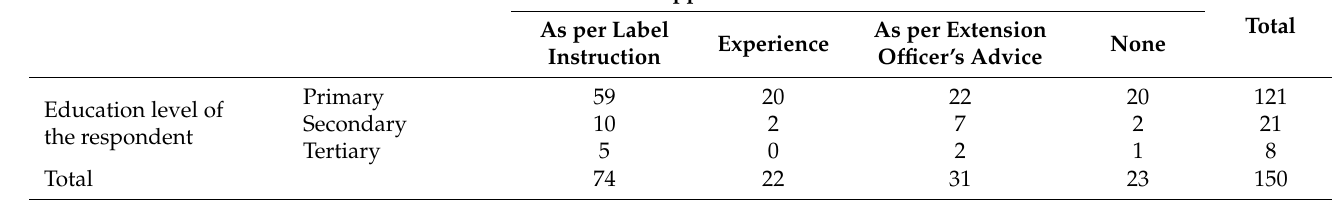
Table 8. Education level of the respondent. Rate of application of pesticides in tomato production